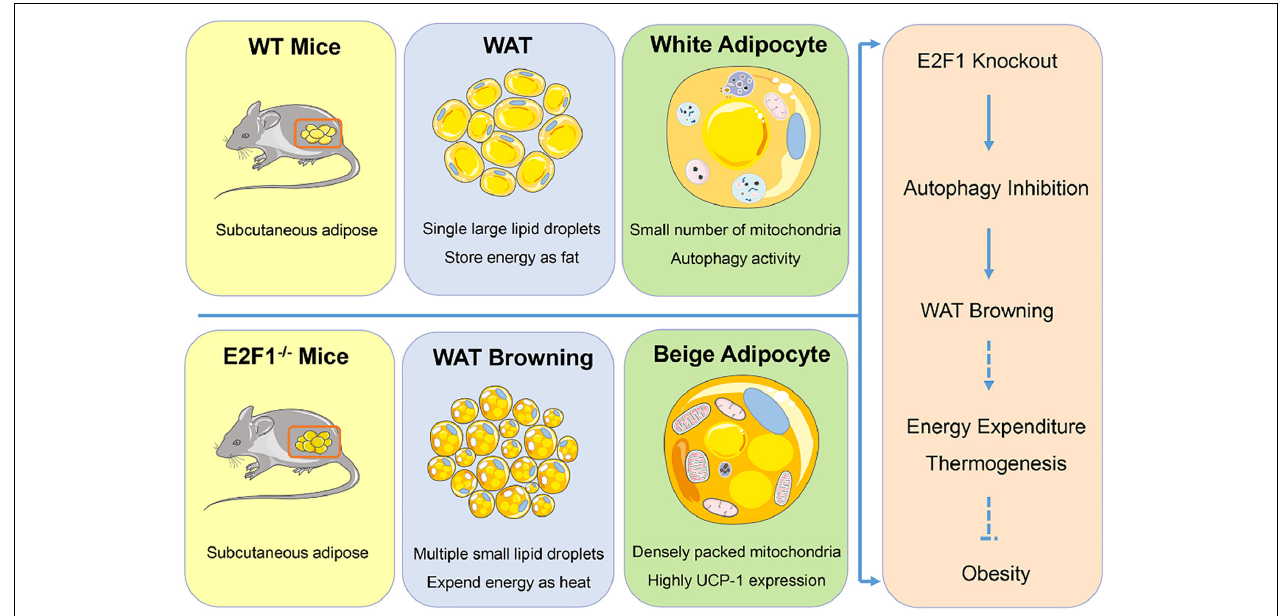
FIGURE 7 | Graphical summary. E2F1 − / − WAT exhibited multiple small lipid droplets, densely packed mitochondria, and highly UCP-1 expression, indicating the browning form. Mechanically, E2F1 knockout suppressed the autophagy activity to promote WAT browning in mice, which was beneficial to expend energy in thermogenic manner for combating